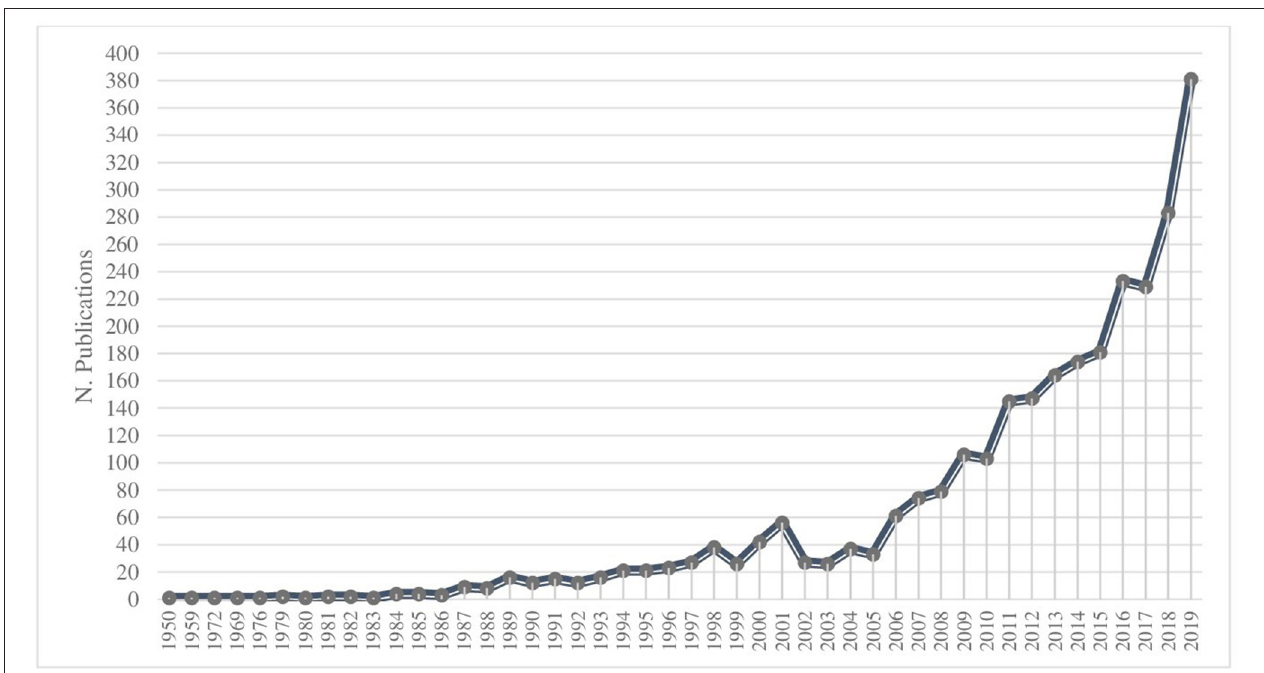
FIGURE 2 | Evaluation of scientific publications per years. Source: Elaborated by the Authors.